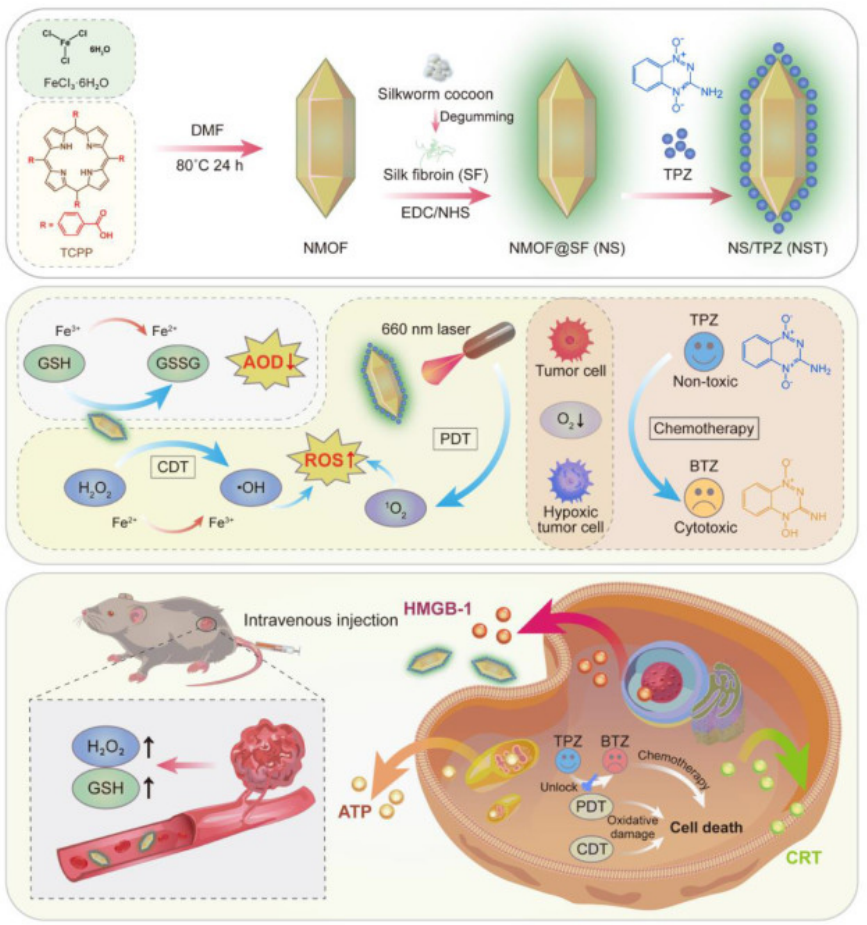
Figure 9. Schematic presentation of the construction procedure of NMOF@SF NPs and their practical mechanism for tumor-specific redox chemodynamic therapy (CDT) combined with photodynamic therapy (PDT) created by Fe (III)-TCPP and glutathione (GSH) upon laser irradiation. Reprinted with permission from [65].